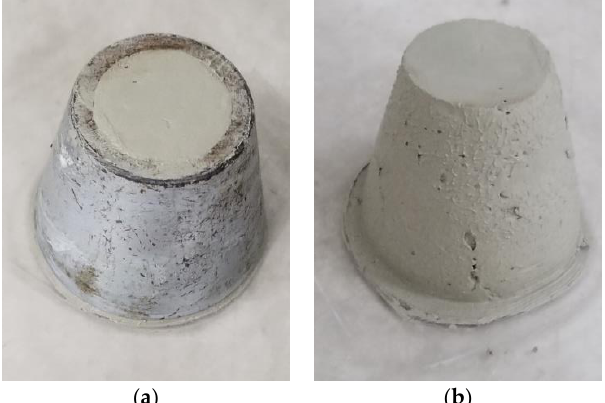
Figure 7. Representative pictures during measuring fluidity of paste: ( a ) a mold filled with paste; ( b ) control paste with W/C of 0.3 after removing a mold.